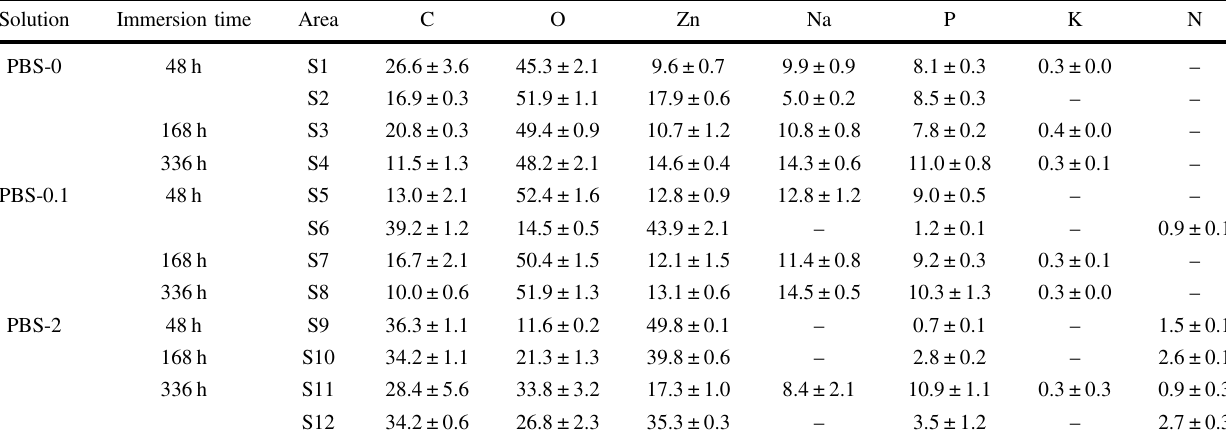
Table 3 Elemental compositions of pure Zn surfaces after immersion in different solutions for different time (Corresponding areas were indicated in Figs. 8 – 10 by yellow squares). Data were expressed as mean ± standard deviation Solution Immersion time